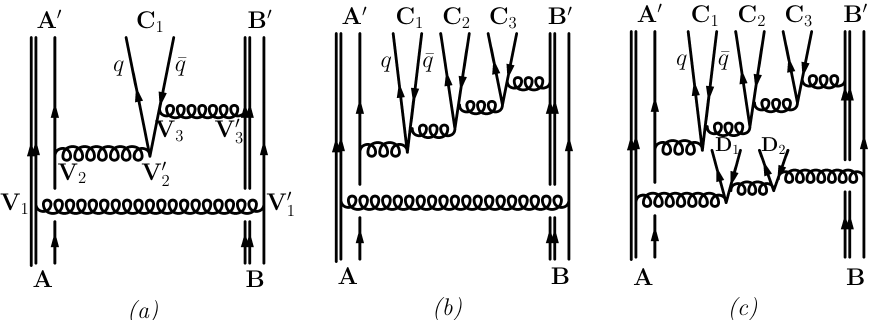
Figure 1 . Feynman diagrams for the production of QCD and QED mesons: ( a ) A + B B 0 + C 1 at low energies, ( b ) A + B A 0 + B 0 + C 1 + C 2 + C 3 : : : at intermediate energies, and ( c ) ! A + B A 0 + B 0 + C 1 + C 2 + C 3 + : : : + D 1 + D 2 + : : : at high energies. The double lines !